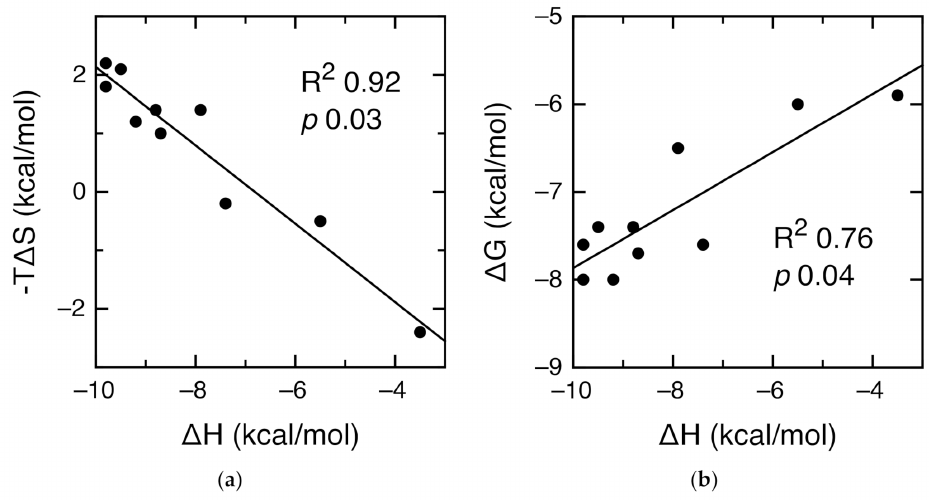
Figure 4. Enthalpy–entropy compensation in the PSD95-PDZ3 interactions with data from this study and from [35]. ( a ) Correlation between -T ∆ S and ∆ H, showing the R 2 and p values. The experimental data are shown in circles and the linear regression as a line, with the equation y = − 4.6 − 0.67x. ( b ) Correlation between ∆ G and ∆ H, showing the R 2 and p values. The experimental data are shown in circles and the linear regression as a line, with the equation y = − 4.6 + 0.33x.